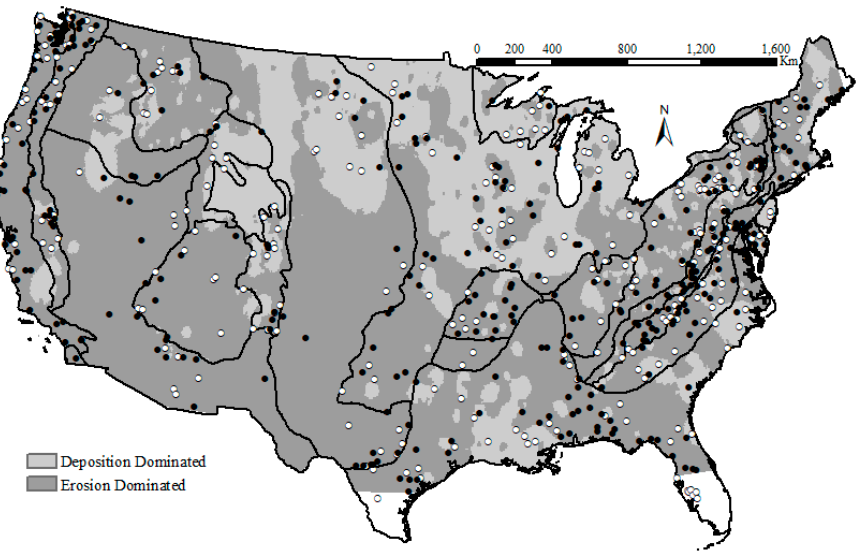
Figure 9. Spatial map showing dominant channel processes over the contiguous U.S. overlaid with points obtained from [36] for aggradation/degradation pattern. Black dots indicate gaging sites where both sources agree for the erosion/deposition pattern; the converse is true for the white dots.